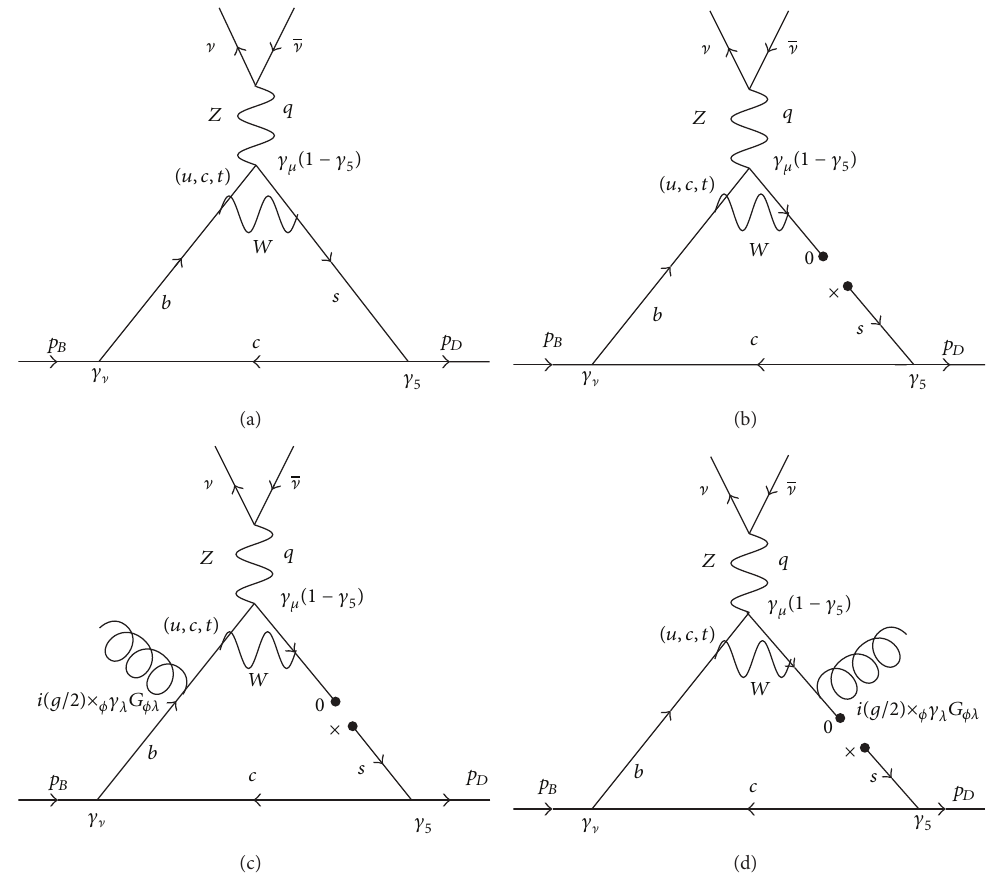
Figure 1: The bare-loop and light quarks condensates contributions to 𝐵 ∗ 𝑐 → 𝐷 𝑠 𝑙 + 𝑙 −